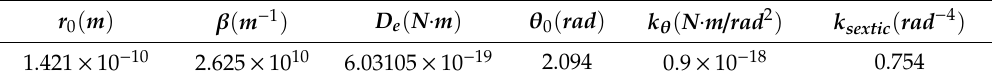
Table 2. The parameters of the modified Morse potential [27,28].